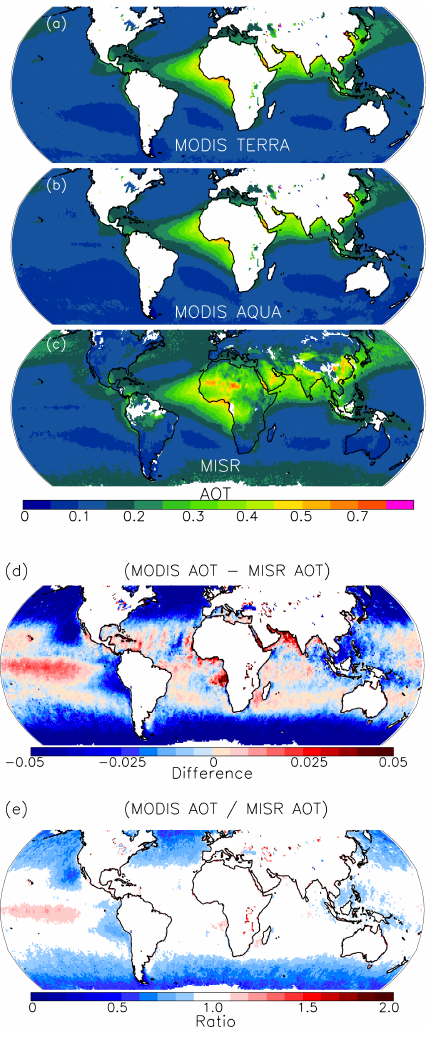
Figure 2. (a) The global distribution of daytime AOTs constructed using 16 years (2000–2015) of monthly averaged over-ocean C6 Terra MODIS AOTs at a 1 ◦ × 1 ◦ (latitude/longitude) resolution. Only those bins with more than 1000 data counts were considered for this analysis. (b) Similar to (a) , but using over-ocean C6 Aqua MODIS AOTs for the study period of 2002–2015. (c) Similar to (a) , but using both over-ocean and over-land Terra MISR AOT data for the study period of 2000–2015. (d) Differences in gridded AOTs between Terra MODIS and Terra MISR. (e) The ratios of gridded AOTs between Terra MODIS and Terra MISR.